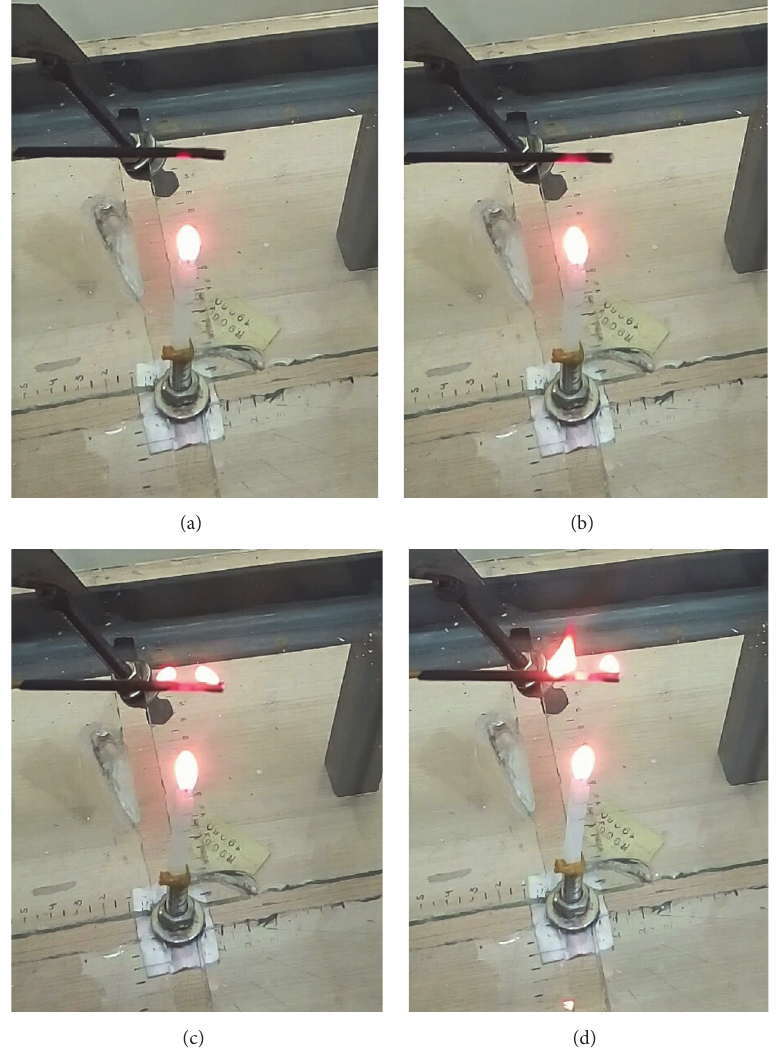
Figure 12: Pictorial view of buoyant convection effect on transitional